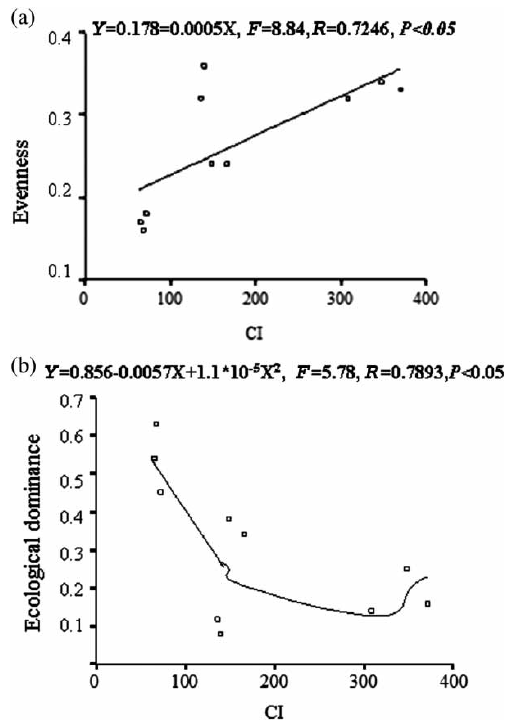
Fig. 4. The relationships between composition index (CI) and evenness ( E ), ecological dominance (ED) ( n (cid:5)